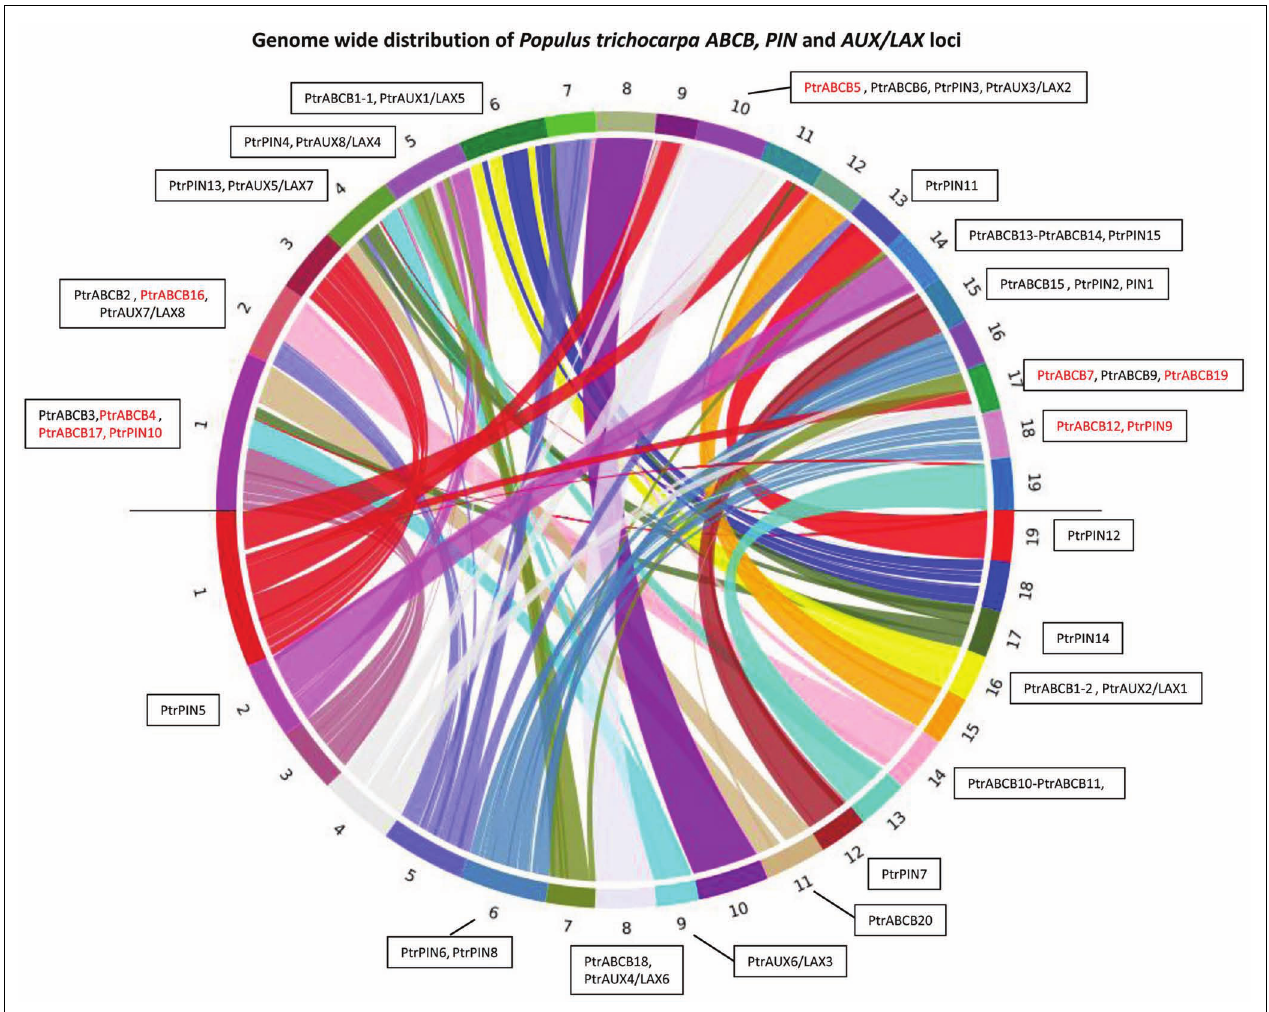
coded ribbons link one region with the correspondent homologous chromosomal segments. All PIN , AUX/LAX , and ABCB genes are assigned to a chromosome based on their map position. Red coded genes do not have any unique match on another locus in the genome. For a detailed list of these genes, see TableA2 in